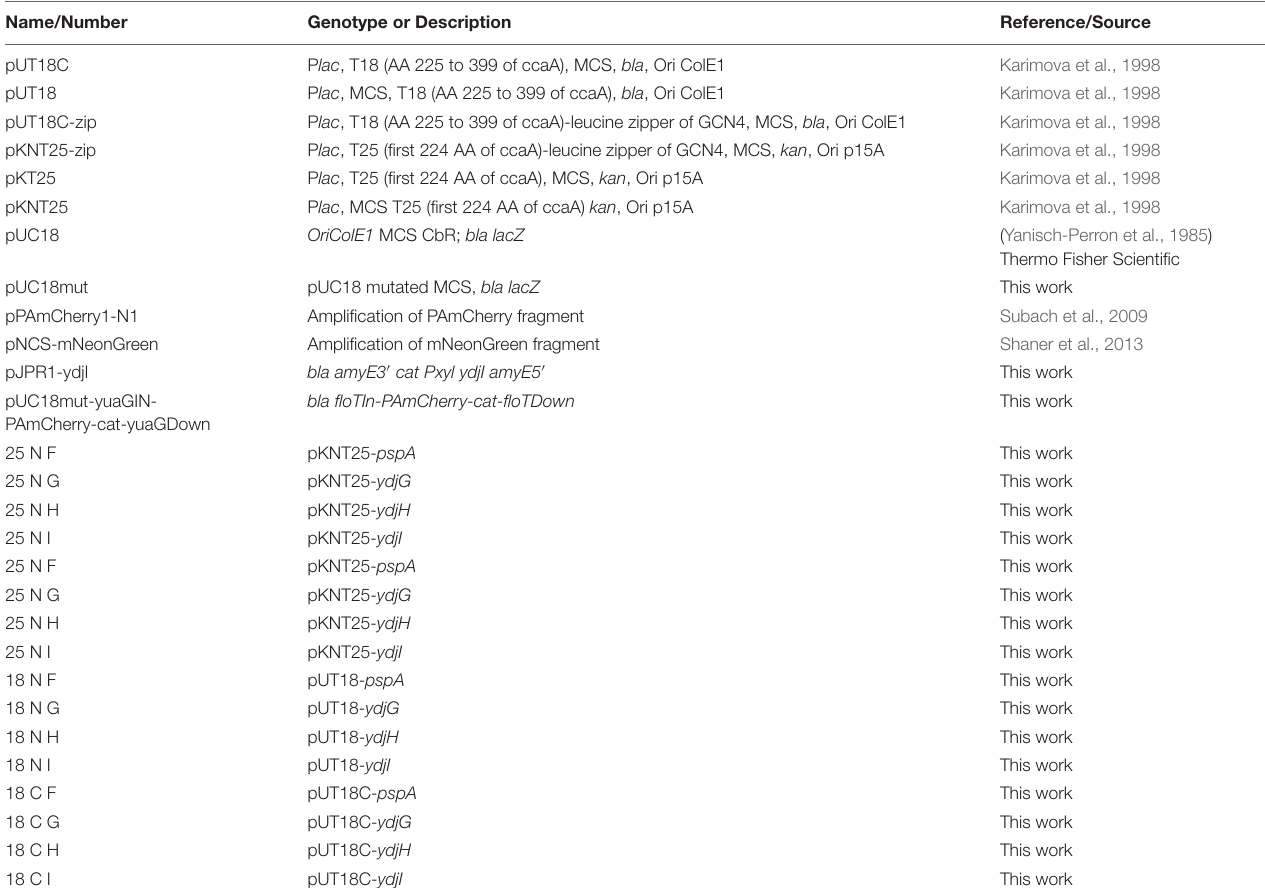
TABLE 3 | Plasmids used in this